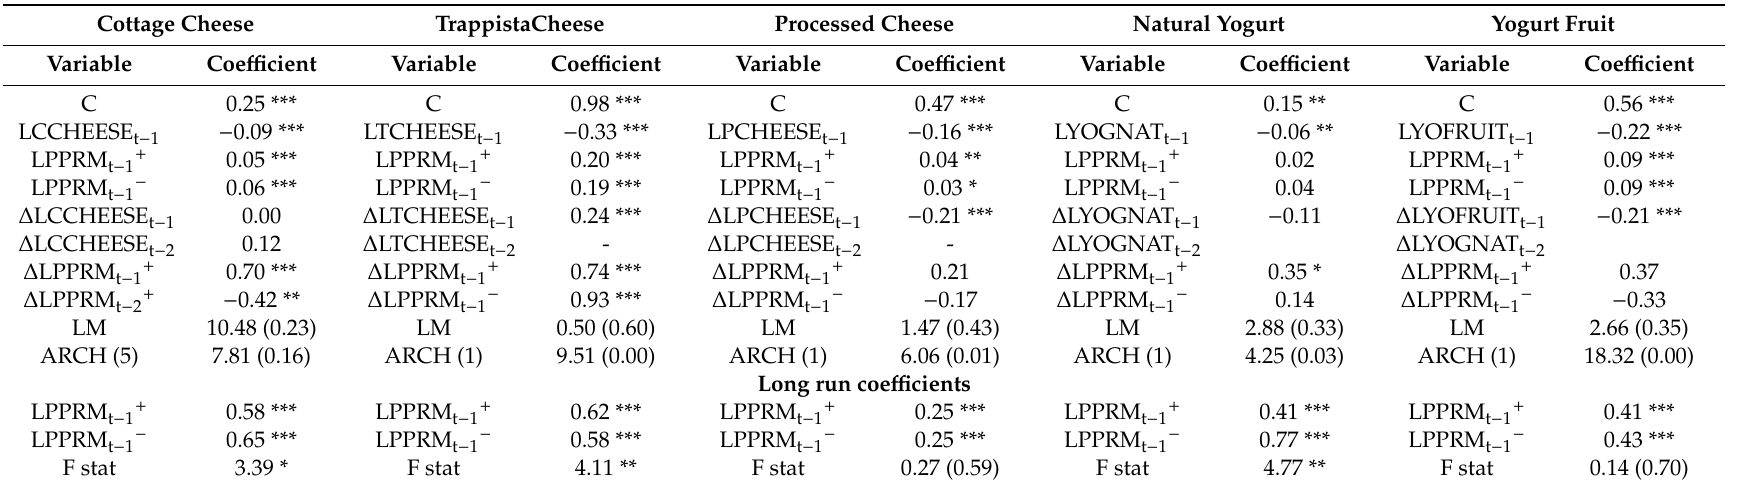
Table 5. NARDL estimation results (dependent variable: LPPRM)